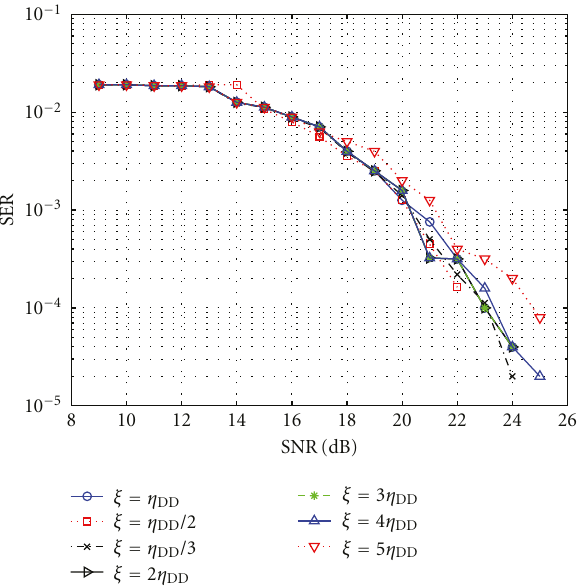
Figure 6: CEQTR SER × SNR having threshold ξ as a parameter. “Brazil A” channel profile, no Doppler. Notice that the best performance is obtained for ξ = η DD , value also found for “Brazil B–E” profiles.